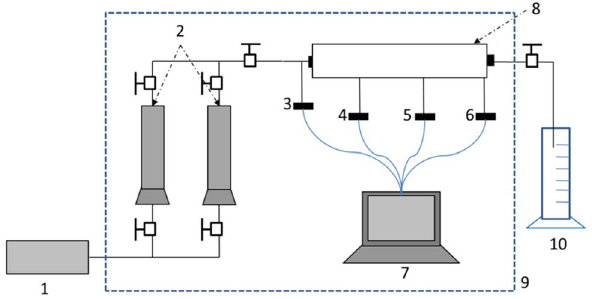
Fig. 1 Diagram of the sandpack flow process. 1—plunger pump; 2— container; 3—injection pressure tap; 4—pressure tap 1; 5—pressure tap 2; 6—pressure tap 3; 7—analysis computer; 8—sandpack; 9— oven; 10—measuring